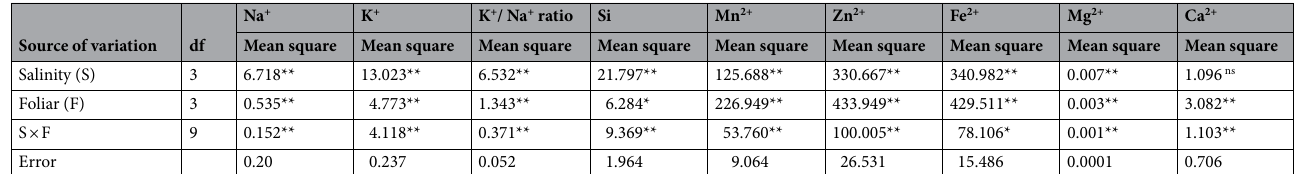
Table 7. Effect of salinity (0, 50, 100, and 150 mM NaCl) and foliar applications (no-foliar, KNO 3 , glucose, and Dobogen) on the mineral content of Tanacetum balsamita plants grown hydroponically in perlite. df, degree of freedom; Na, Sodium; K, Potassium; Si, Silicon; Mn, Manganese; Zn, Zinc; Fe, Iron; Mg, Magnesium; Ca, Calcium; ns, non-significant. *Significant difference at P ≤ 5% and **Significant difference at P ≤ 1%, following two-way